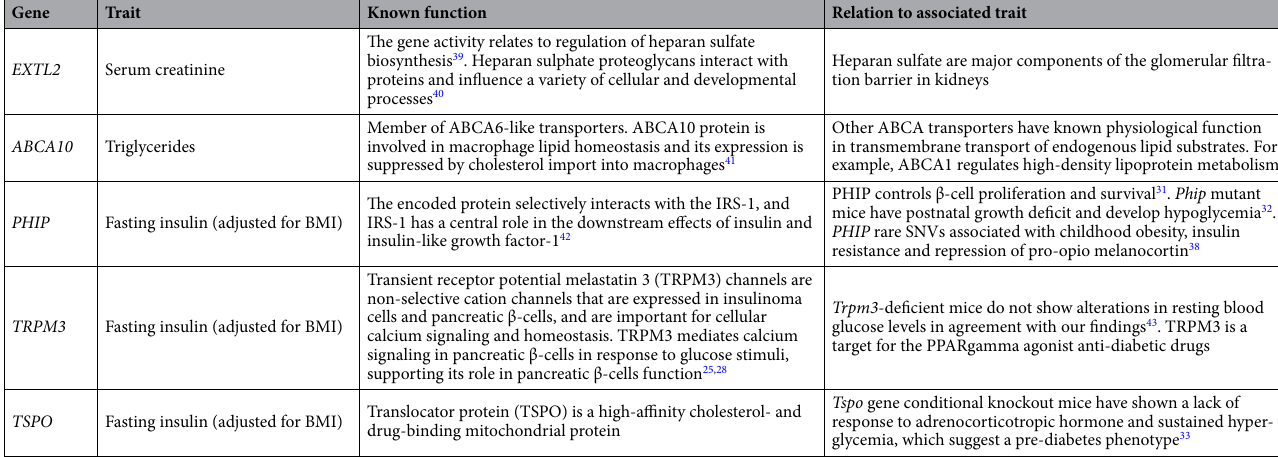
Table 3. Supporting evidence for genes and associated traits. For replication of gene-trait associations, see Table